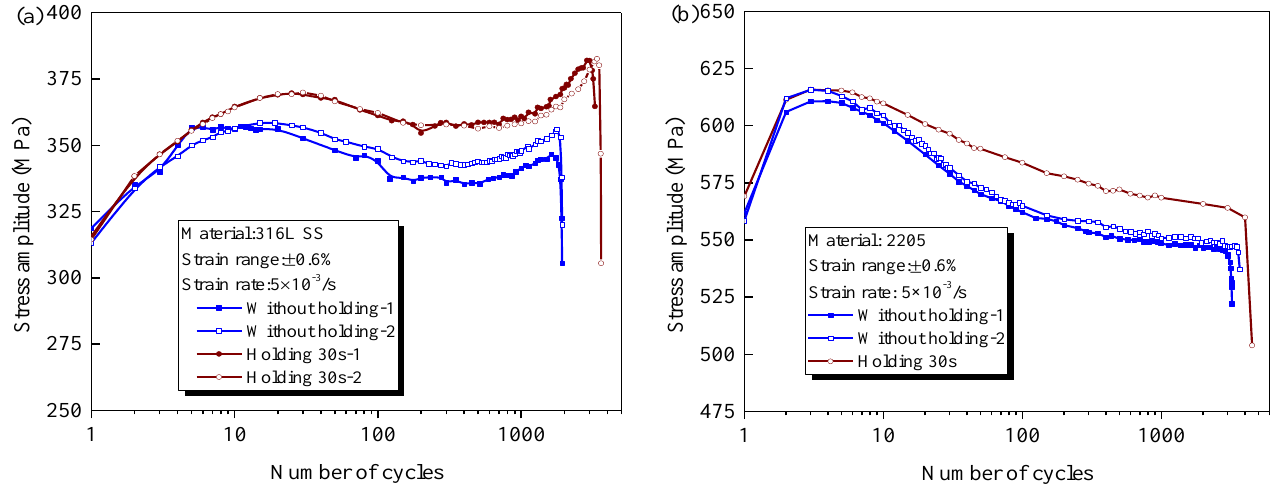
Figure 7. Cyclic stress amplitude for ( a ) 316L and ( b ) 2205 under effect of holding at strain rate of 5 × 10 −3 s −1. The stress response is determined by the magnitude of elastic strain. For the tensile- holding strain-controlled LCF, the holding provides enough time for the dislocation slip movements. Thus, the hysteretic plastic deformation forms gradually and some elastic strain is recovered when the total strain is constant, resulting in stress relaxation